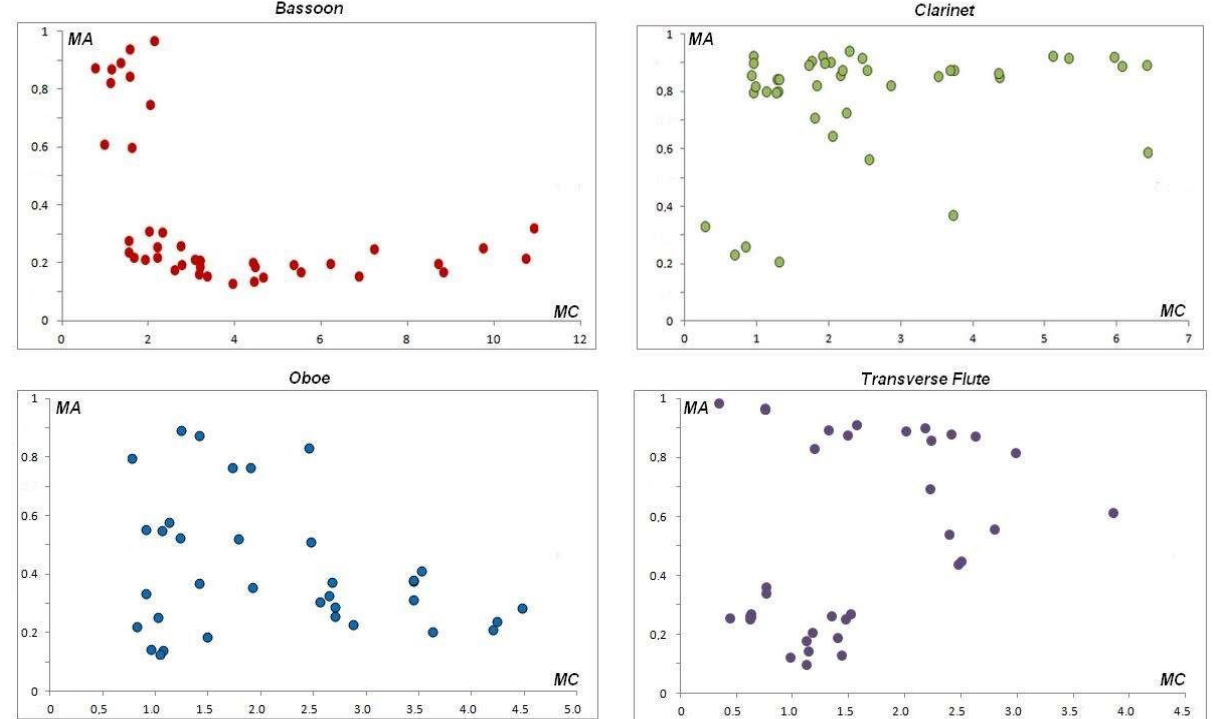
Figure 18. Two-dimensional representation in the MA – MC plane of the timbral space of coefficients for the selected aerophones.